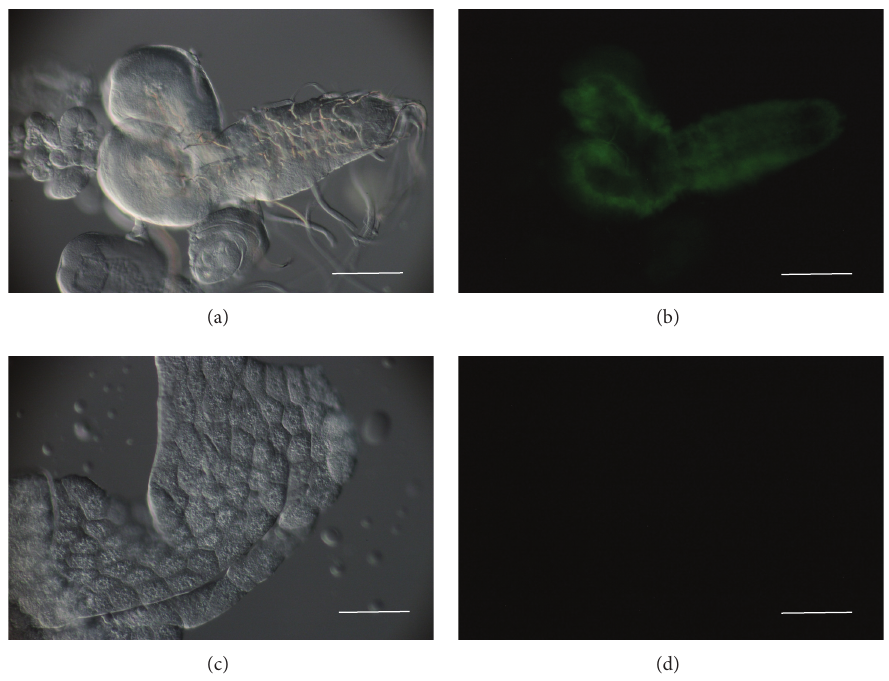
Figure 1: Expression pattern of the GFP-tagged protein trap. imp expression in third instar larva was examined using a protein trap strain ZCL0310, which expresses GFP-Imp chimeric protein in endogenous imp -expressing tissues. Bright field (a, c) and intrinsic GFP (b, d) images areshown.TheGFPsignal wasdetected inthecentral nervoussystem(CNS)(a, b),butonly inasubsetofneuronswithintheCNS.Incontrast, GFP-Imp was not confirmed in the fat body (c, d). Bar, 100 𝜇